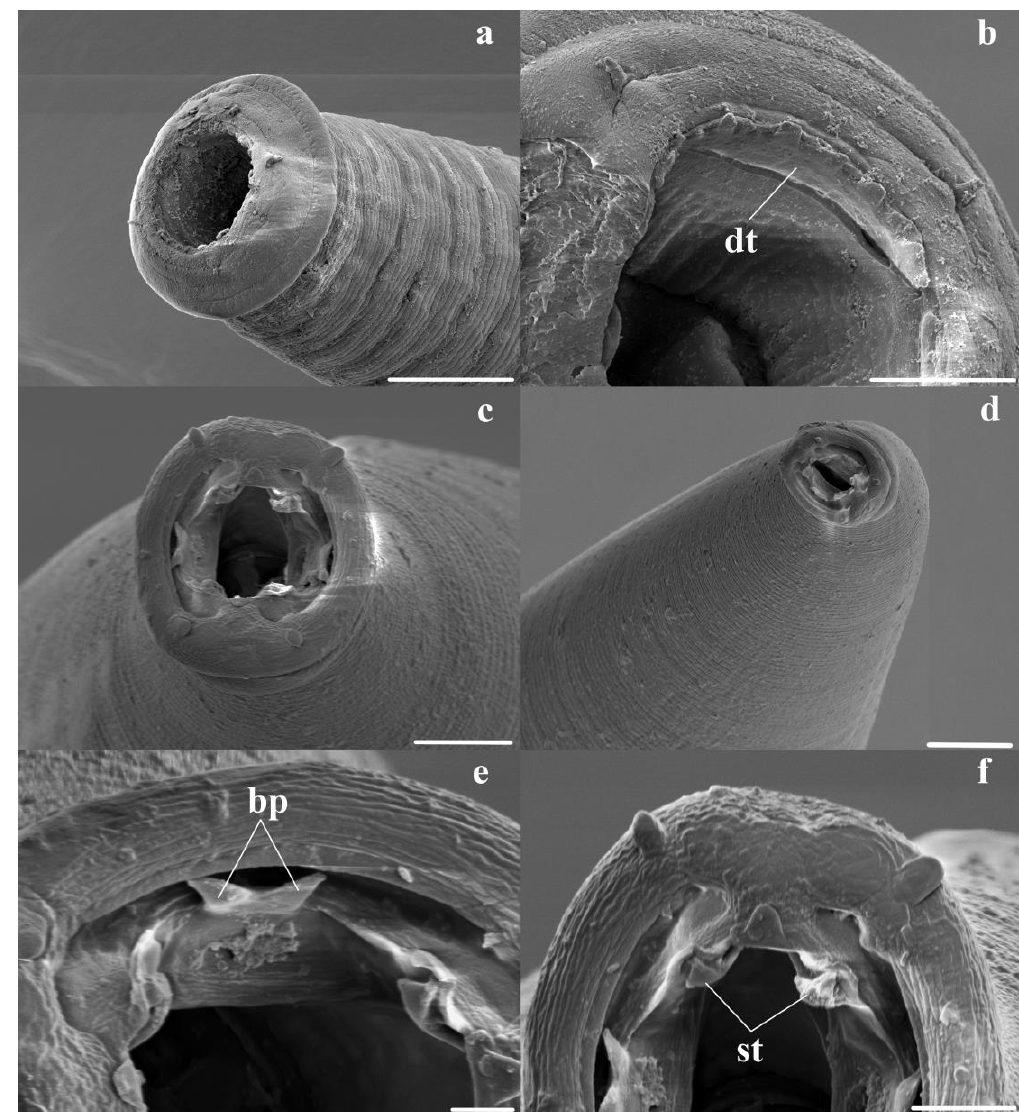
Figure 3. Scanning electron photomicrographs of the cephalic extremities and mouth openings. (a) Anterior extremity of Torquenema toraliforme n. comb. showing collar; (b) Buccal capsule, apical view of Torquenema toraliforme n. comb.(dt = denticles); (c) Buccal capsule, apical view of Wallabicola dissimilis n. comb.; (d) Anterior extremity of Wallabicola dissimilis n. comb., showing ventral deviation of head; (e,f) Buccal capsule, apical view of Wallabicola dissimilis n. comb. showing bifid projection (bp) (e) and sub-median teeth (st) (f). Scale-bars: (a), 50µm; (b, d), 20µm; (c), 10µm; (e), 2µm; (f), 5µm.